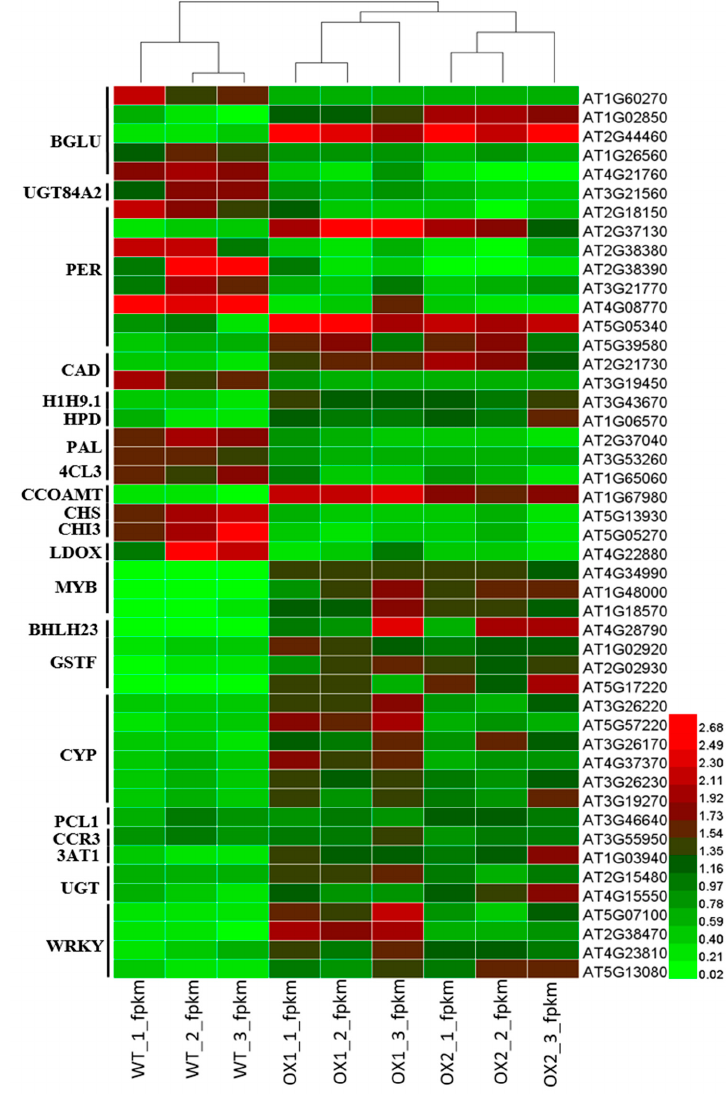
Figure 8. Expression levels of potential DEGs for flavonoid production in transgenic plant ( A. thaliana ). The heat map was created through the log2-fold change (log2FC) and mean value calculated from three replicates of RNA-Seq. data. The color shows the fold change of DEGs under OX1, OX2, and WT, displayed on the right side. The means of RNA-seq. analysis data are the ± SD ( n = 3) and means showing effective difference ( p <